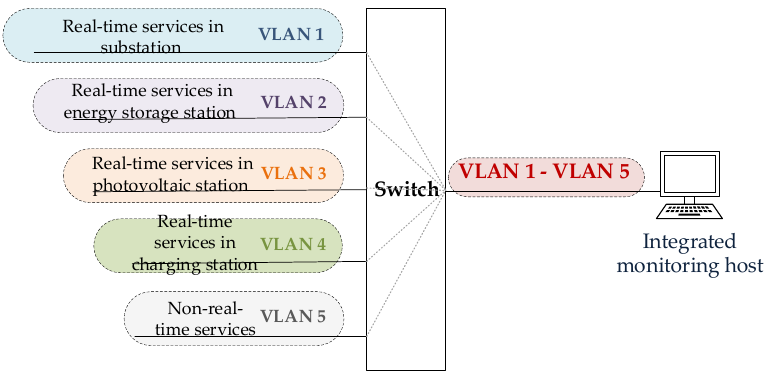
Figure 8. VLAN division scheme of communication services in SESt.